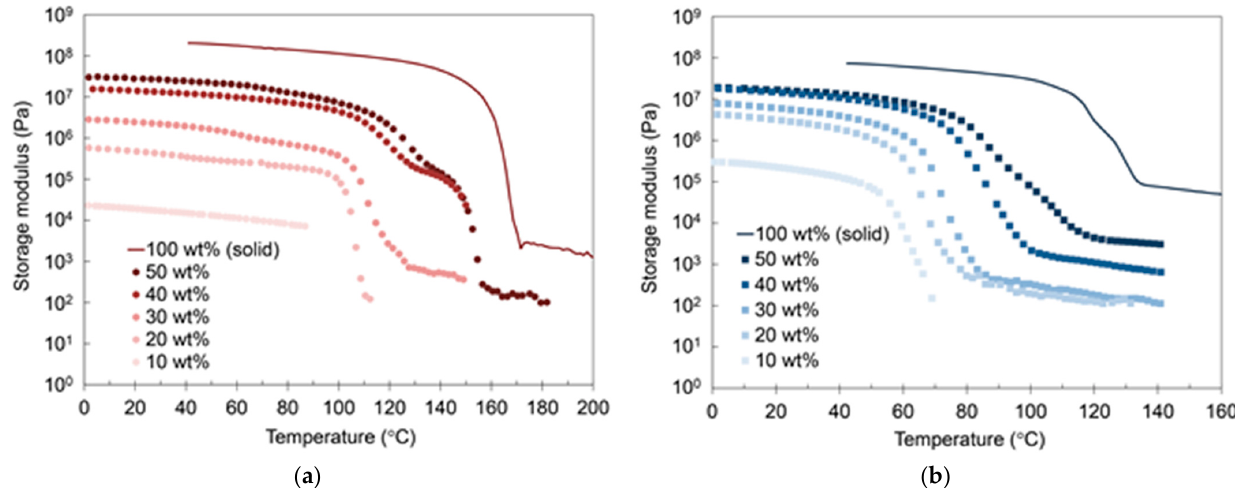
Figure 3. Storage modulus of PP-gels with different PP concentrations as a function of temperature: ( a ) isotactic polypropylene (iPP) (Mw = 190,000)/1,2,3,4-tetrahydronaphthalene (tetralin) gels; ( b ) syndiotactic polypropylene (sPP) (Mw = 174,000)/tetralin gels.